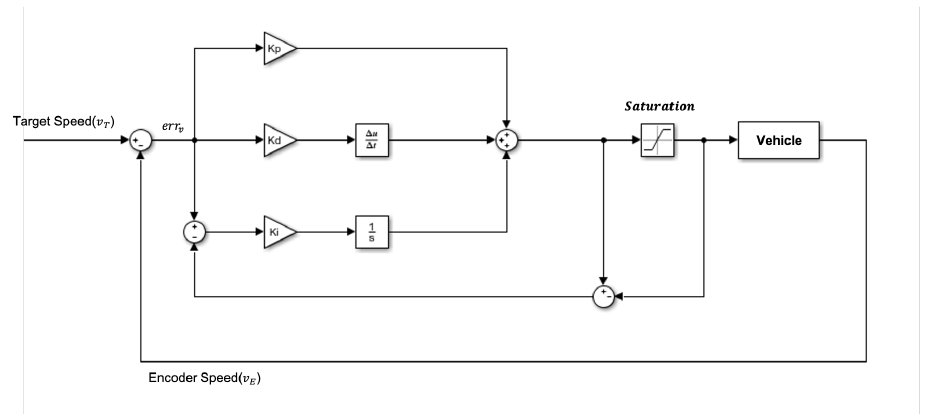
Figure 18. Speed controller block